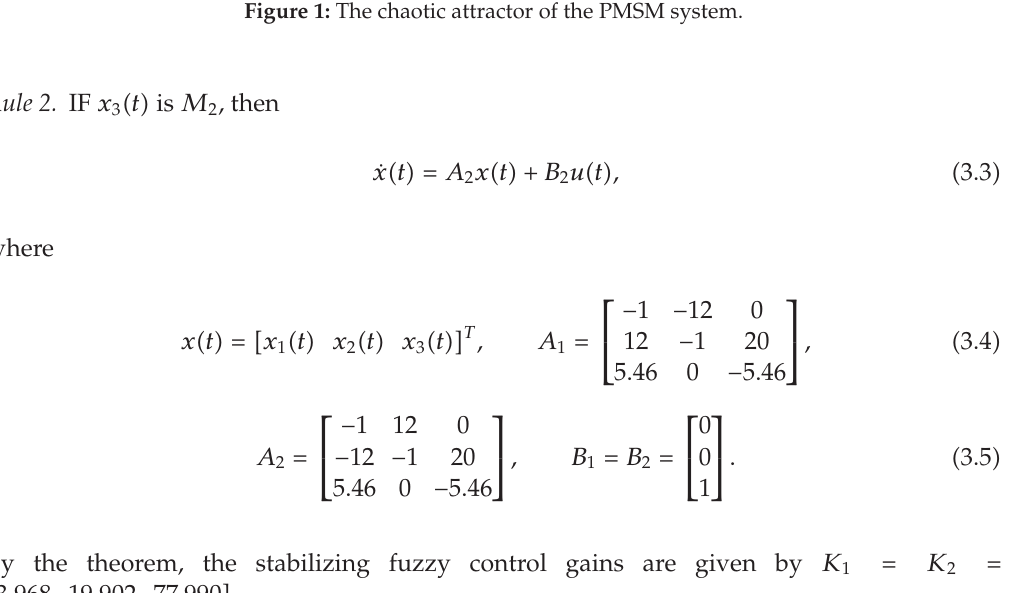
Figure 1: The chaotic attractor of the PMSM